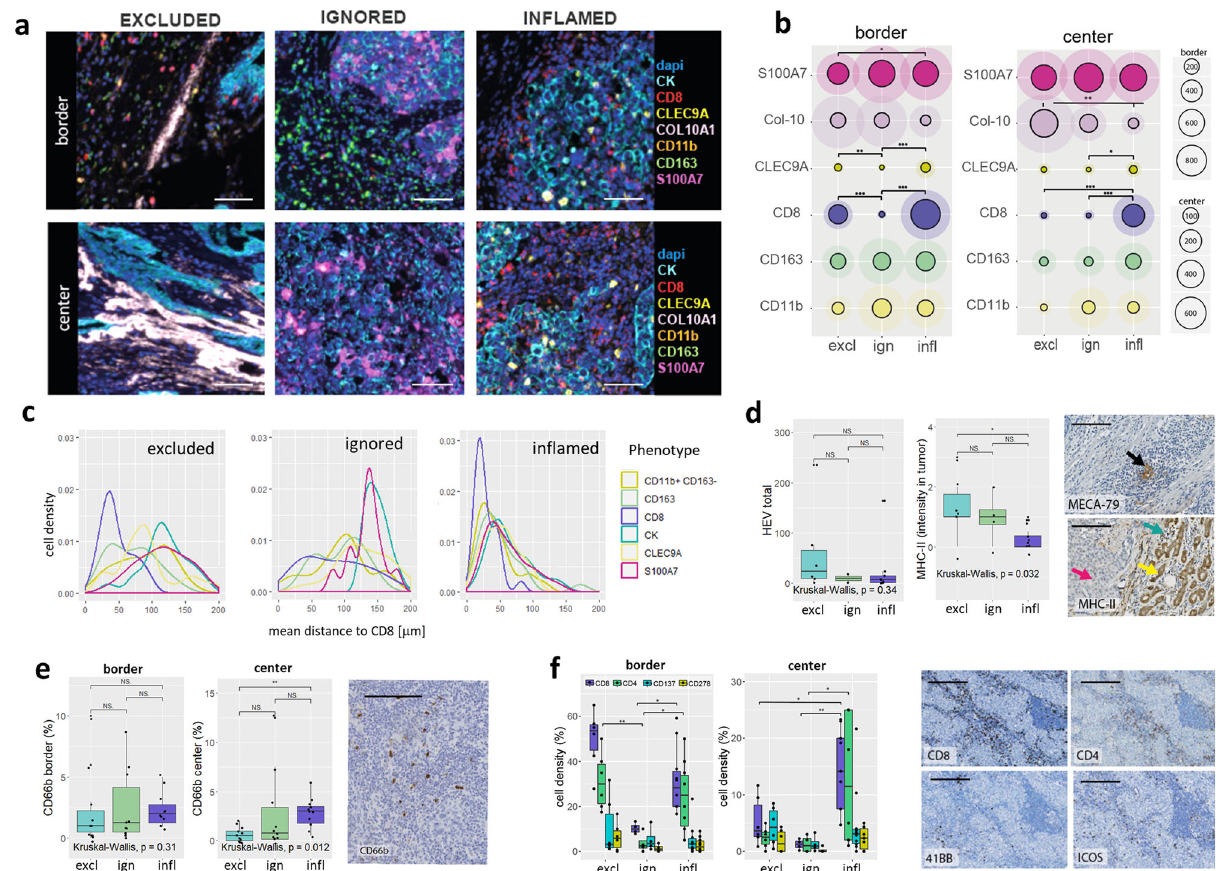
Fig. 5 Spatial immunophenotypes are characterized by distinct T cell evasive mechanisms. a Representative images of cells and molecules related to spatial phenotypes (spatial phenotype panel) at the tumor border and center (CD11b (orange), CD163 (green), CD8 (red), CK (cyan), CLEC9A (yellow), or S100A7 (magenta); scalebar corresponds to 50 μ m). b Circle plots show mean and SD of cell densities at border and center regions per mm 2 for CD11b (orange), CD163 (green), CD8 (purple), CK (cyan), CLEC9A (yellow), or S100A7 (magenta); Collagen-10 (pink) is displayed as positive tissue area in μ m 2 /100 for visualization purpose ( n = 68 TNBC comprising n = 20 excluded, n = 22 ignored, and n = 26 in fl amed). c Histograms show mean distances in μ m between CD8 + T cells and CD11b (orange), CD163 (green), CD8 (purple), CK (cyan), CLEC9A (yellow), or S100A7 (magenta) (x-axis) versus cell densities (y-axis) ( n = 68 TNBC of which n = 20 excluded, n = 22 ignored, and n = 26 in fl amed). d Boxplots show median with 25th – 75th percentile and range (outliers are displayed as dots) of numbers of high endothelial venules (HEV, identi fi ed via MECA-79 staining, black arrow) and MHC-II expression of tumor cells for excluded (cyan), ignored (green), and in fl amed (purple) TNBC (no distinction between border and center, pink arrow: tumor cells; yellow arrow: adjacent normal breast lobules; green arrow: immune cells, scalebar corresponds to 100 μ m, n = 20 TNBC, of which n = 6 excluded, n = 4 ignored, and n = 10 in fl amed). e Boxplots show median with 25th – 75th percentile and range (outliers are displayed as dots) of neutrophil densities (CD66b + ) at border and center for excluded (cyan), ignored (green), and in fl amed (purple) TNBC and the representative image is shown, scalebar corresponds to 100 μ m, ( n = 32 TNBC, of which = 11 excluded, n = 10 ignored, and n = 11 in fl amed). f Boxplots show median with 25th – 75th percentile and range (outliers are displayed as dots) of numbers of different T cell markers stained on consecutive slides, and representative images (CD8 (purple), CD4 (green), 41BB (cyan), and ICOS (yellow); scalebar corresponds to 100 μ m, n = 20 TNBC, of which n = 6 excluded, n = 4 ignored, and n = 10 in fl amed). Signi fi cant differences are: *** p < 0.001; ** p < 0.01; * p < 0.05, NS, p > 0.05 (Kruskal – Wallis, one-sided). Source data are provided within source data fi